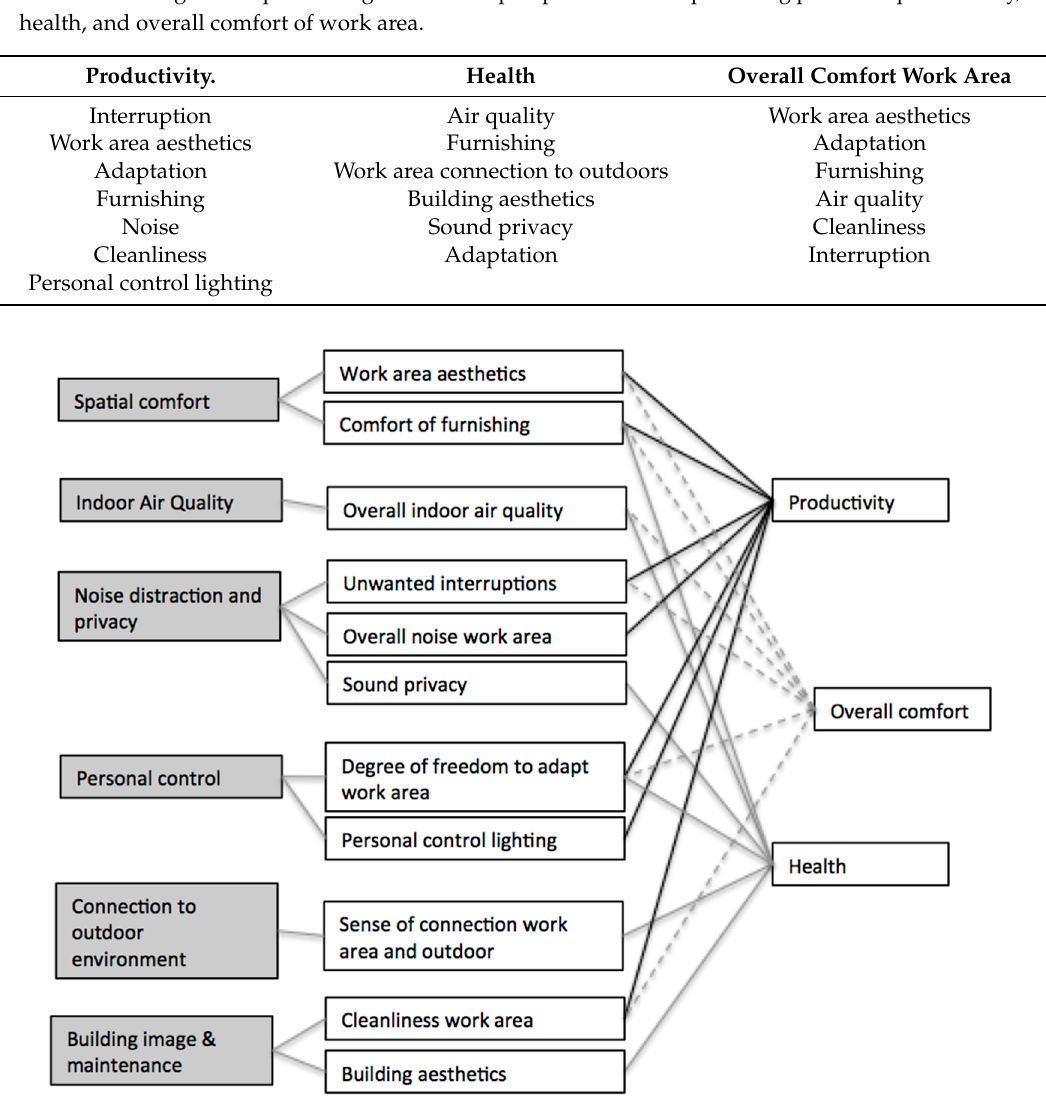
Figure 2. Best-performing features of open-plan offices for predicting perceived productivity, health, and overall comfort of work area.